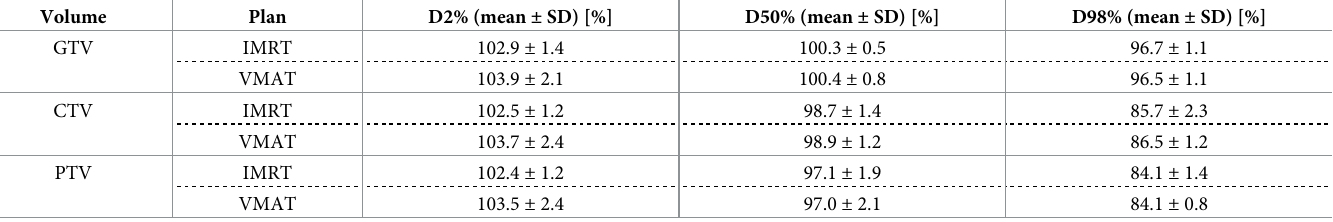
Treatment planning, organs at risk and constraints Both VMAT and fixed-field IMRT planning resulted in isodose distributions that covered GTV, CTV, and PTV as intended (Table 2 and Fig 1). Median NTCP for brain was < 5% as required and was not different between fixed-field IMRT and VMAT plans (p = 0.29). Mean dose for all other constraints was significantly lower in VMAT compared to fixed-field IMRT plans (Table 3 and Fig 2). Constraints were met in 21/40 eyes, 7/40 corneae, and 24/40 lacrimal glands in total. When evaluating if constraints were met per dog, this was the case in 8/20, 1/20 and 10/20 dogs for both eyes, corneae and lac- rimal glands, respectively. Constraints were met in 3/10 eyes in the higher dose area in IMRT and 5/10 VMAT plans, respectively, and 6/10 eyes in the lower dose area in IMRT and 7/10 VMAT plans, respectively. Constraints were met in the lacrimal gland in the higher dose area in 4/10 IMRT and 6/10 VMAT plans and in the lower dose area in 5/10 IMRT and 9/10 VMAT plans, respectively. For the cornea in the high dose area, constraints were met in 0/10 IMRT and 1/10 VMAT plans, respectively. For the cornea in the low dose area, constraints were met in 2/10 IMRT and 4/10 VMAT plans, respectively. Table 2. Mean relative doses for target volumes.